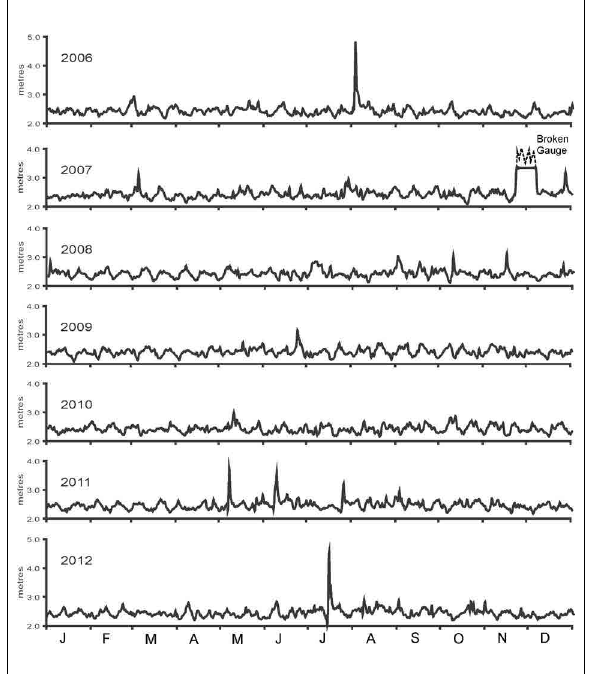
Filtered water levels measured at the Department of Water Affairs N2 water level recorder from 2006 to